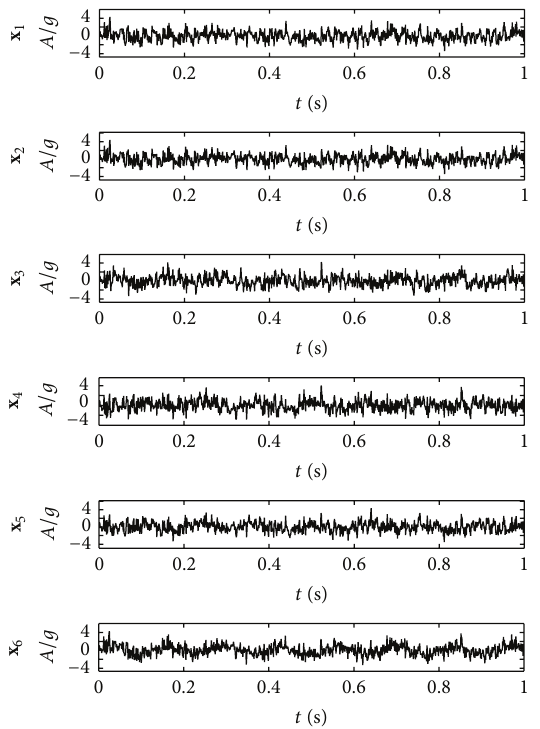
Figure 2: Waveforms of the mixed signals.